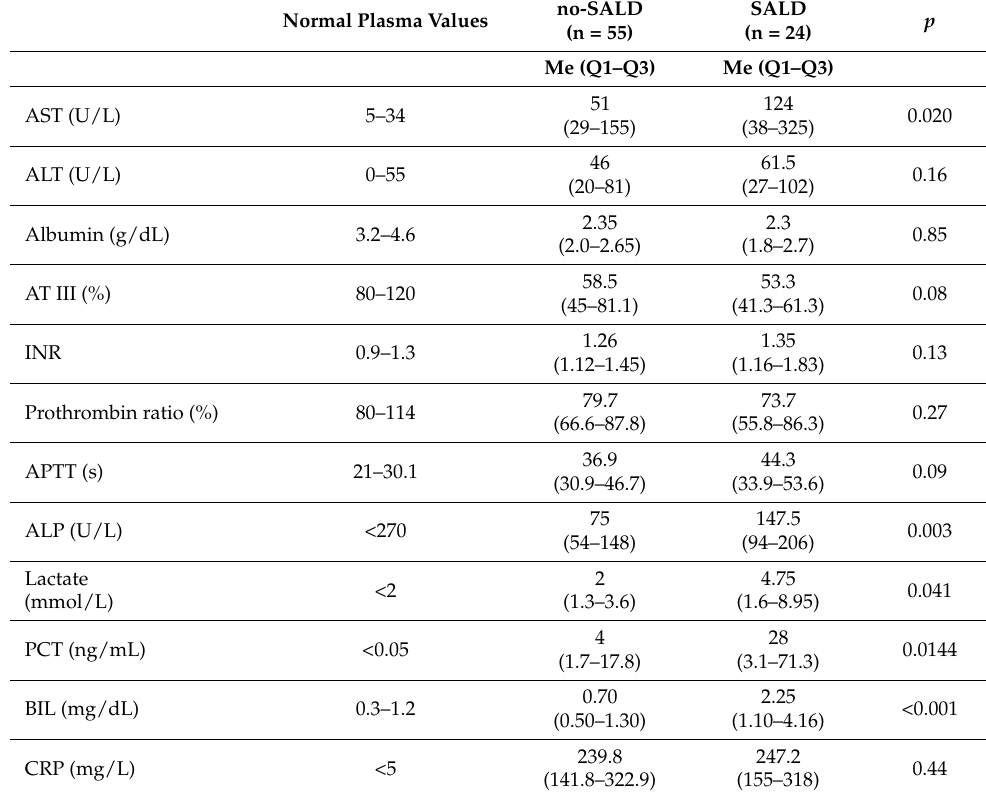
Table 4. Routinely measured biomarkers.